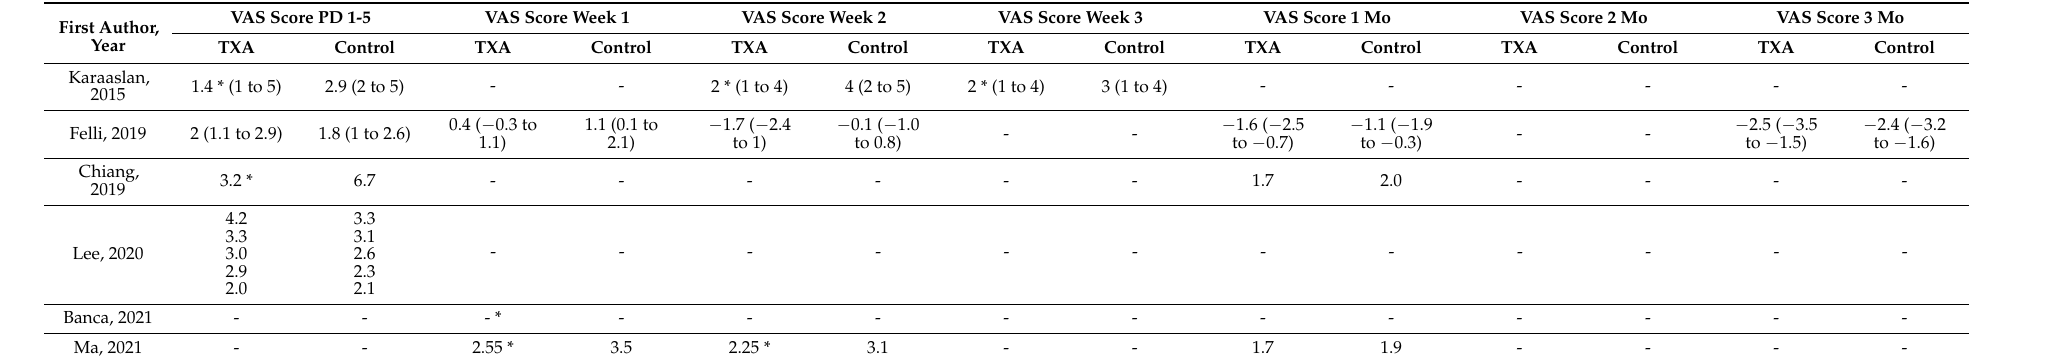
Table 4. VAS outcome values for all included studies for all recorded